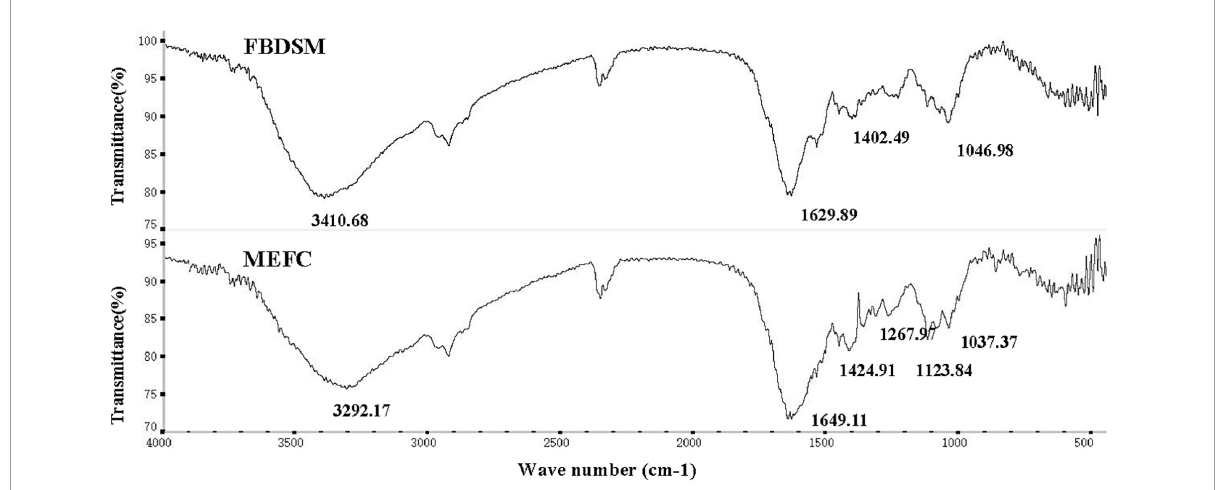
FIGURE3 Fourier transform infrared spectroscopy analysis. FBDSM: fermented bean dregs and soybean meal; MEFC: mineral element fermentation complexes.